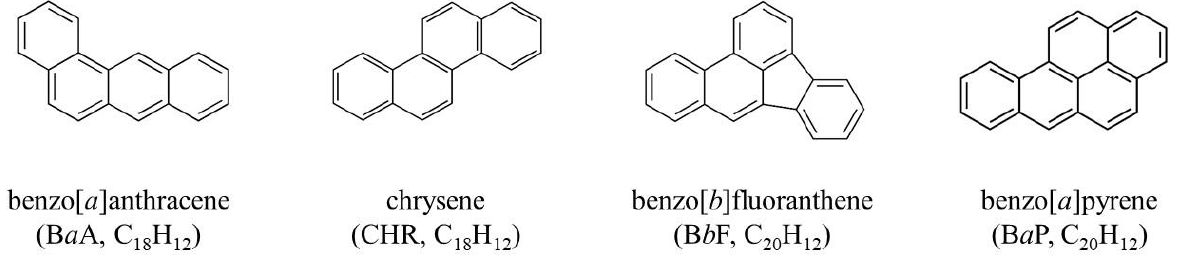
Figure 1. Structure, name, and molecular formula of four polycyclic aromatic hydrocarbons (PAHs) (B a A, CHR, B b F, and B a P).